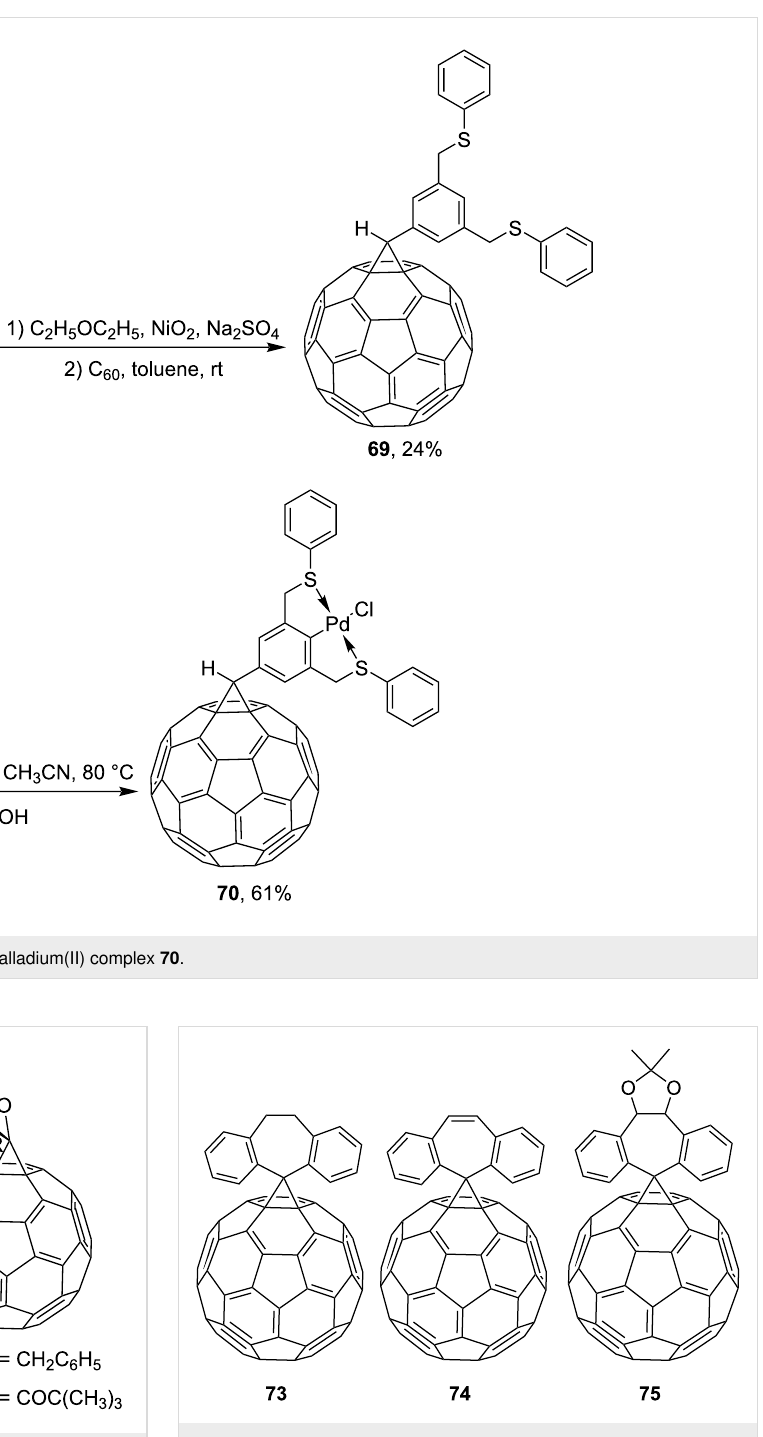
Figure 7: Structures of spiromethanofullerenes 73–75